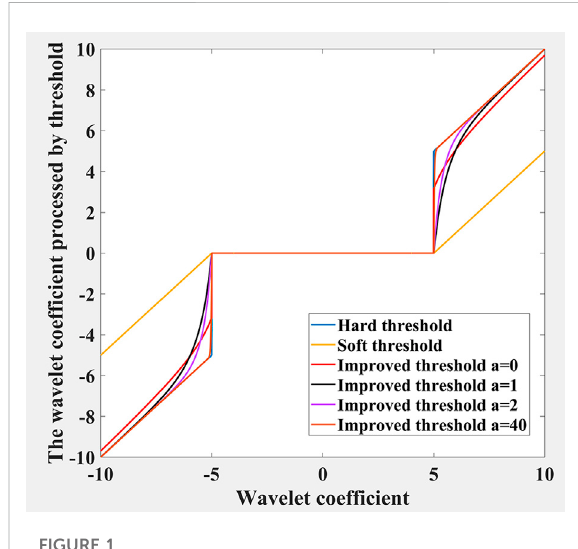
FIGURE 1 Comparison of different thresholding